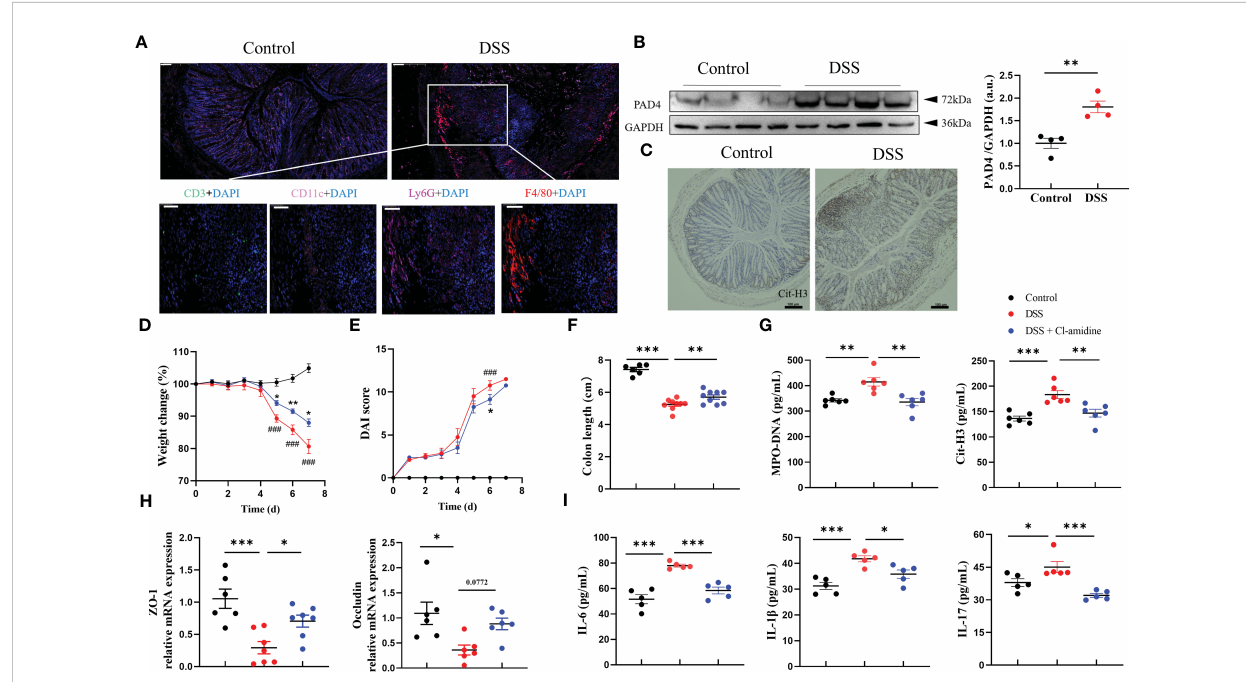
FIGURE 1 PAD4 Inhibitor diminished NETs formation and ameliorated DSS-induced acute colitis. (A) Representative multicolor immuno fl uorescence staining of colon sections, stained for CD3 (green), CD11c (pink), Ly6G (rose-carmine), F4/80 (red) and DNA (DAPI, blue). (B) Western blot analysis of PAD4 in colon tissue. (C) Representative immunohistochemical images of Cit-H3 positive cells in colon sections. The effect of Cl-amidine on disease indexes in colitis mice: Body weight (D) , DAI score (E) ( ### P<0.001 compared with Control group, * P<0.05 , ** P<0.01 compared with DSS group), colon length (F) (n=8-10). (G) The levels of MPO-DNA and Cit-H3 in serum (n=6). (H) RT-qPCR of ZO-1 and Occludin in colon tissue (n=6-8). (I) The levels of IL-6, IL-1 b and IL-17 in colon tissue (n=5). Bars represent 100 m m. * P<0.05 , ** P<0.01 , *** P<0.001